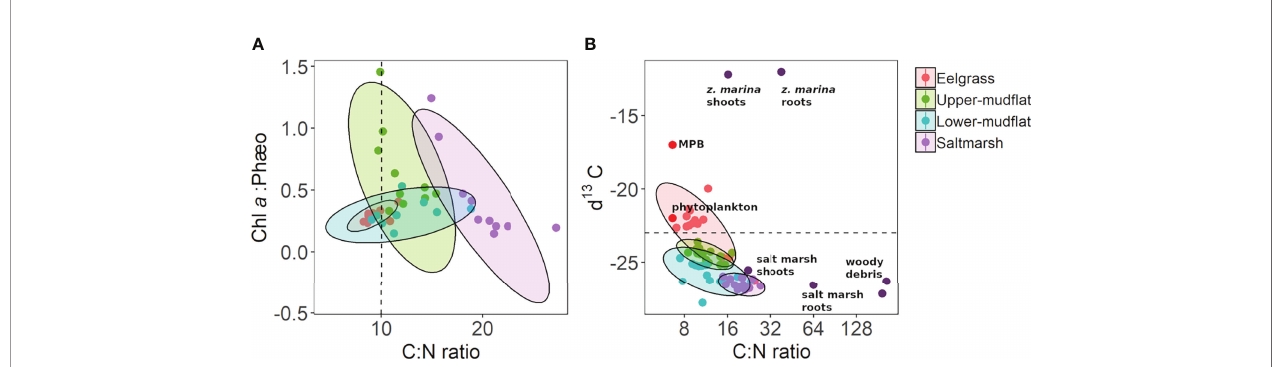
FIGURE 7 | Relationship between C:N ratio to sediment properties: (A) chlorophyll a (chl a )/phæopigment ratio vs. C:N ratio, with hatched line on the x-axis to denote generally labile (C:N <10) and recalcitrant (C:N >10) material; (B) d 13 C vs. C:N ratio plot of sediment cores collected from the Cowichan Estuary, with dark- purple labelled points denoting vegetation end-members from the Cowichan Estuary, with phytoplankton and microphytobenthos (MPB) d 13 C and C:N estimates from literature (Red fi eld et al., 1963, France, 1995). The hatched line on the y-axis denotes marine ( d 13 C <23 ‰ ) and terrestrial ( d 13 C >23 ‰ ). Ellipses delineate the 95% con fi dence interval for each of the habitats, assuming a multivariate t distribution.